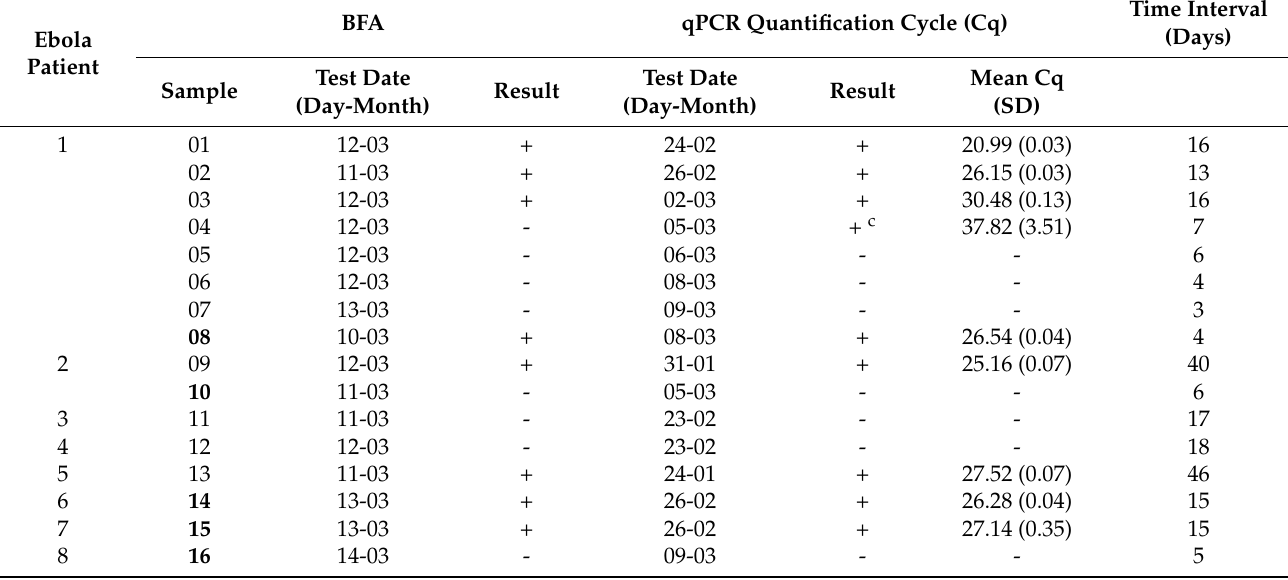
Table 1. Comparison of the BFA a and qPCR results b